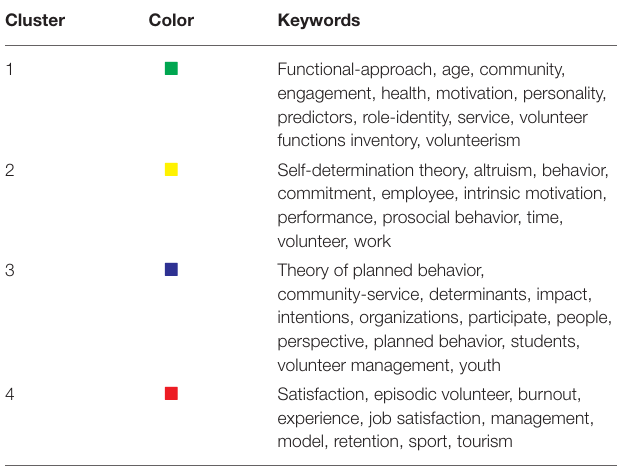
TABLE 9 | Cluster of keywords in the volunteer motivation research field. Cluster